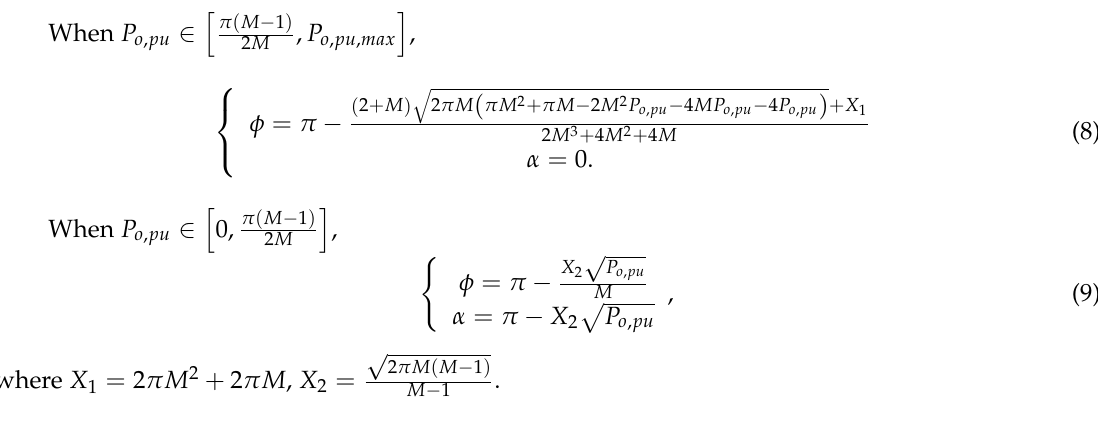
Figure 9. New equivalent circuit corresponding to interval 3 in Mode